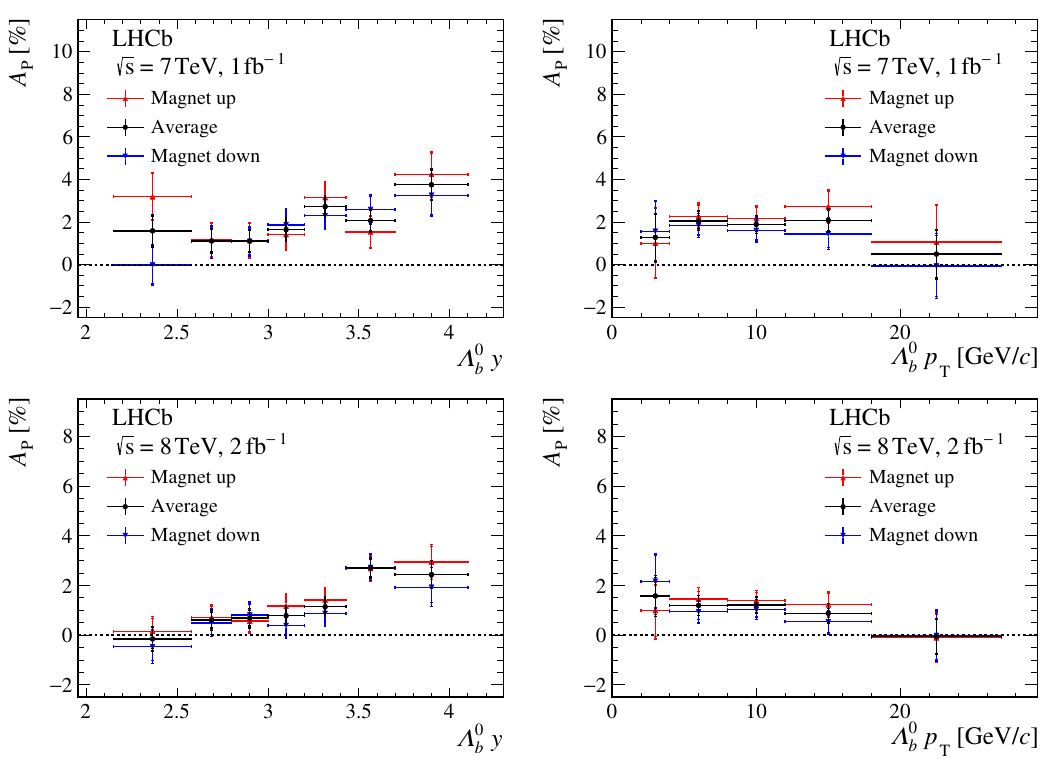
Figure 14 . Measured (cid:3) 0 production asymmetry versus (left) rapidity and (right) transverse mo- b mentum separately for data recorded at centre-of-mass energies of (top) 7 and (bottom) 8 TeV. The measured production asymmetries are shown separately for (red) magnet up, (blue) magnet down and their (black) average. The uncertainties are the quadratic sums of statistical and systematic